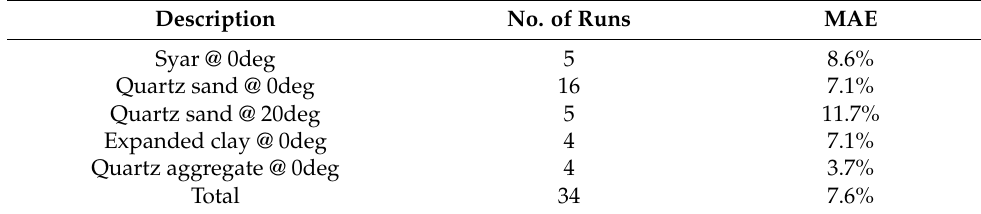
Table 6. Summary of average mean absolute errors.